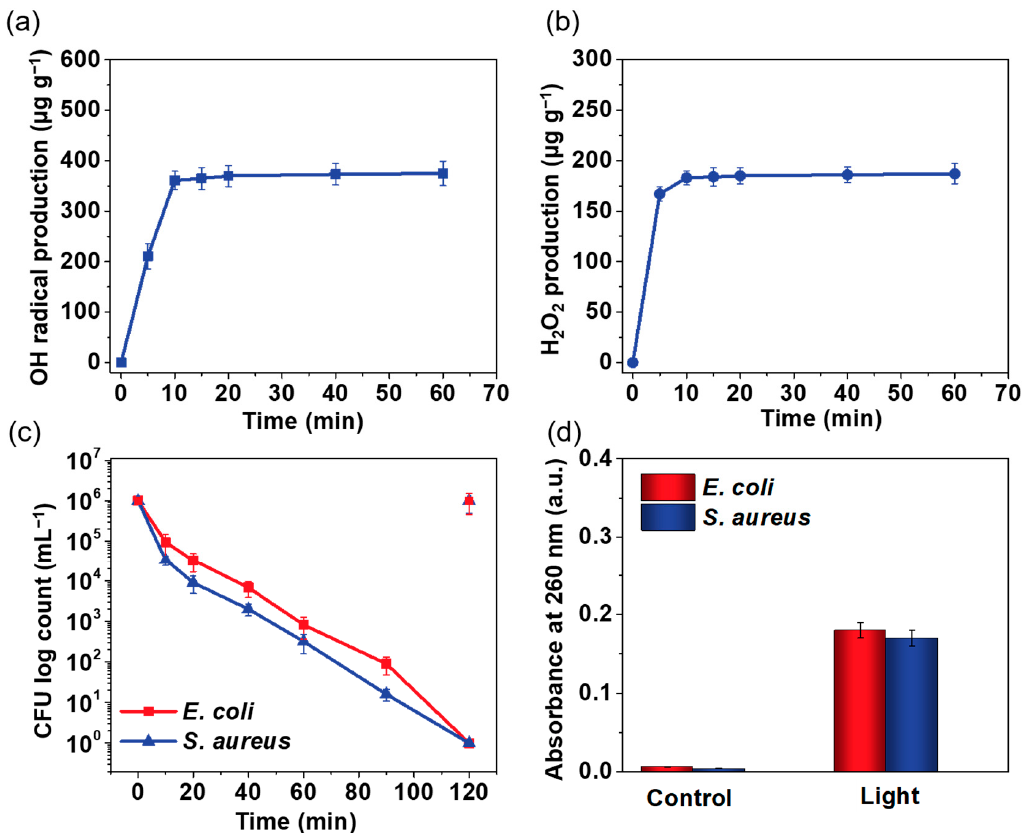
Figure 6. The respective concentrations of ( a ) OH • and ( b ) H 2 O 2 produced by the G-SF/PVA BNM under dark conditions. ( c ) The biocidal activity against E. coli and S. aureus of the G-SF/PVA BNM under dark conditions. ( d ) Measurements of the leakage of nucleic acid from the E. coli cells and S. aureus cells.